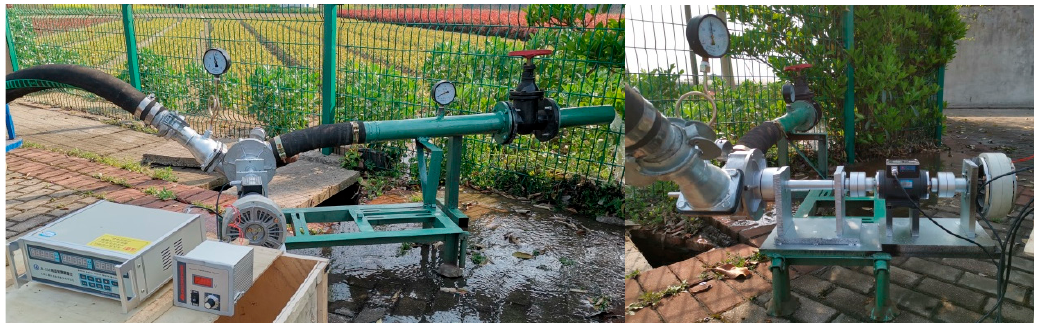
Figure 3. Experiment rig.